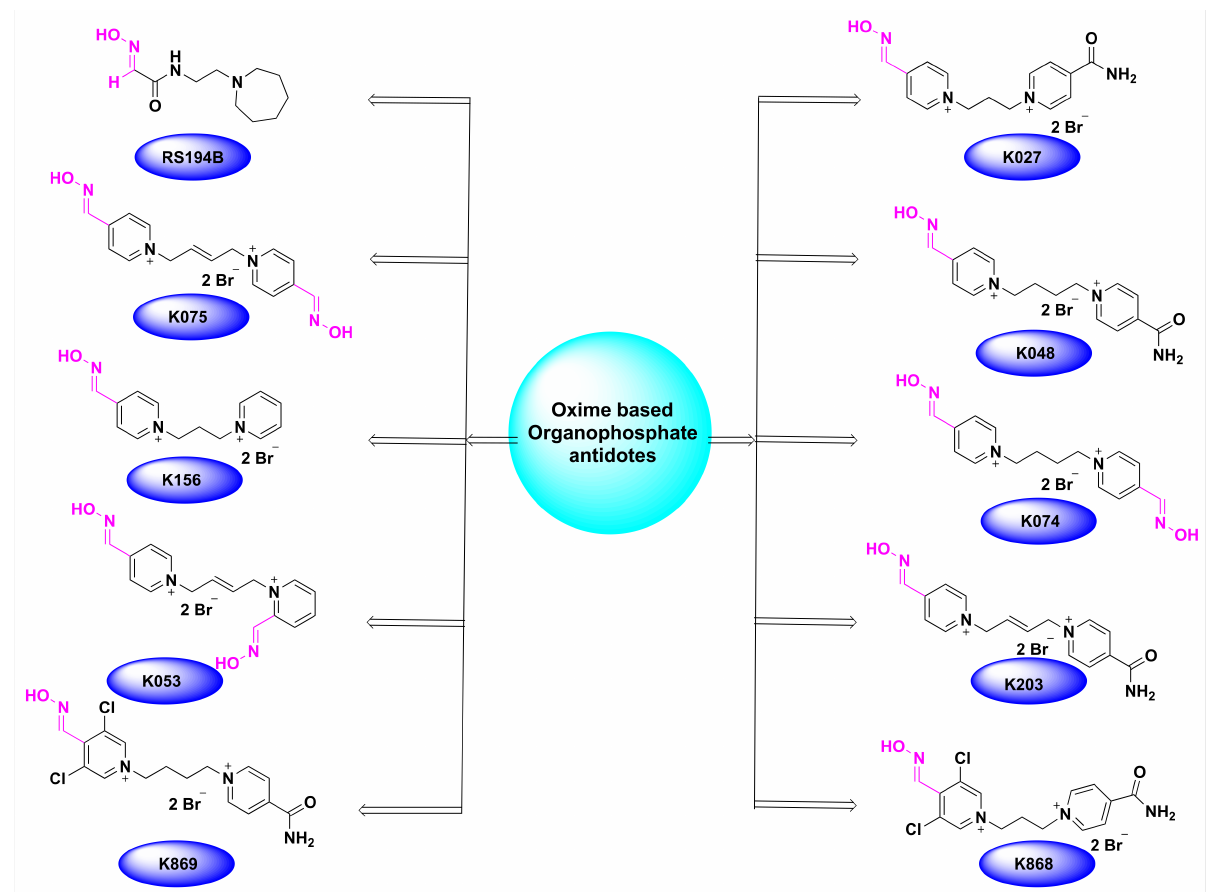
Figure 9. Chemical structures of oxime-based organophosphate